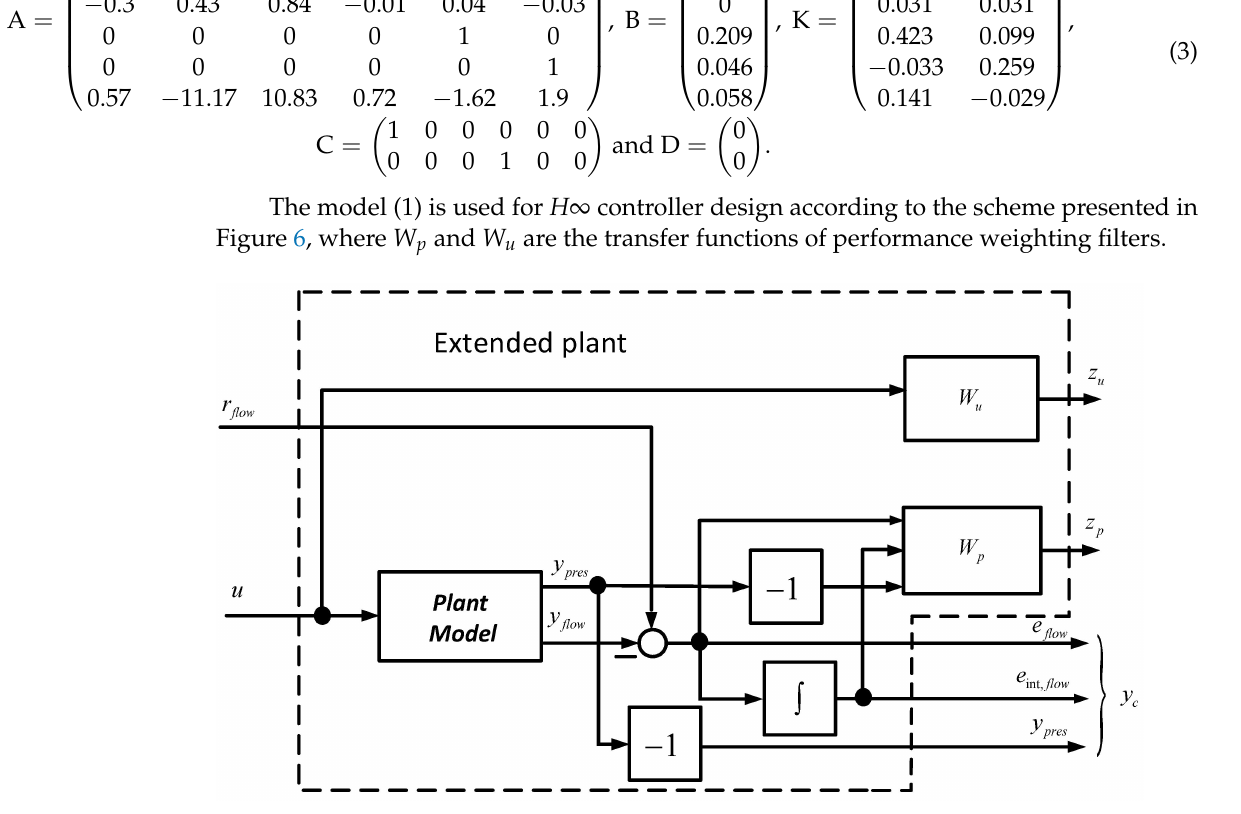
Figure 6. Structure scheme of extended plant used for H ∞ controller